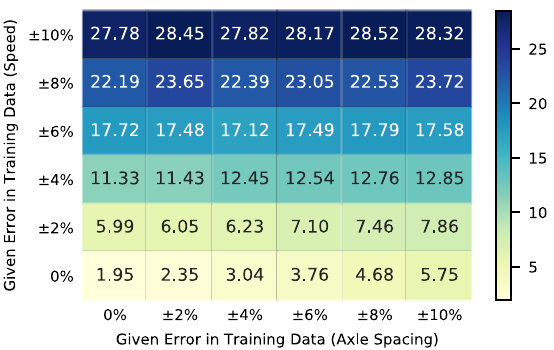
Figure 11. Identification error (%) of axle weights of conventional BWIM algorithm with error-included speed and axle spacing information (Two-axle Trucks).